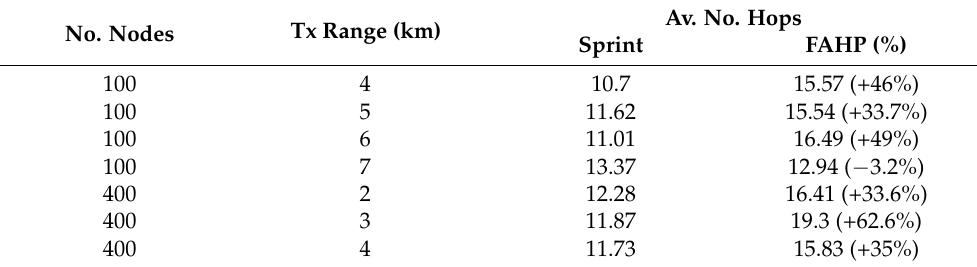
Table 10. Statistical comparison for average No.